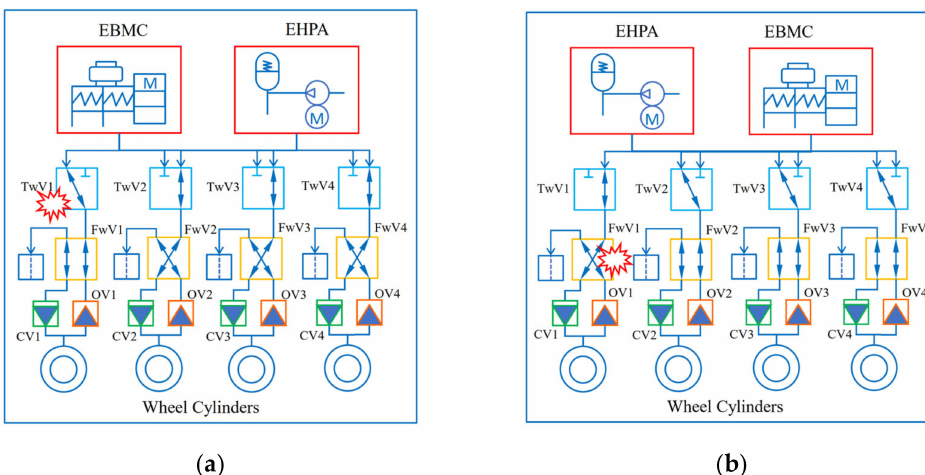
Figure 4. Degraded initiative braking F2 modes. F2 represents for the braking failure type 2 in hydraulic flow switcher layer. ( a ) Braking with TwV failure; ( b ) Braking with FwV